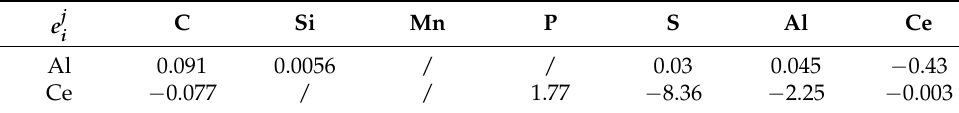
Table 3. Activity interaction coefficients in steel at 1873